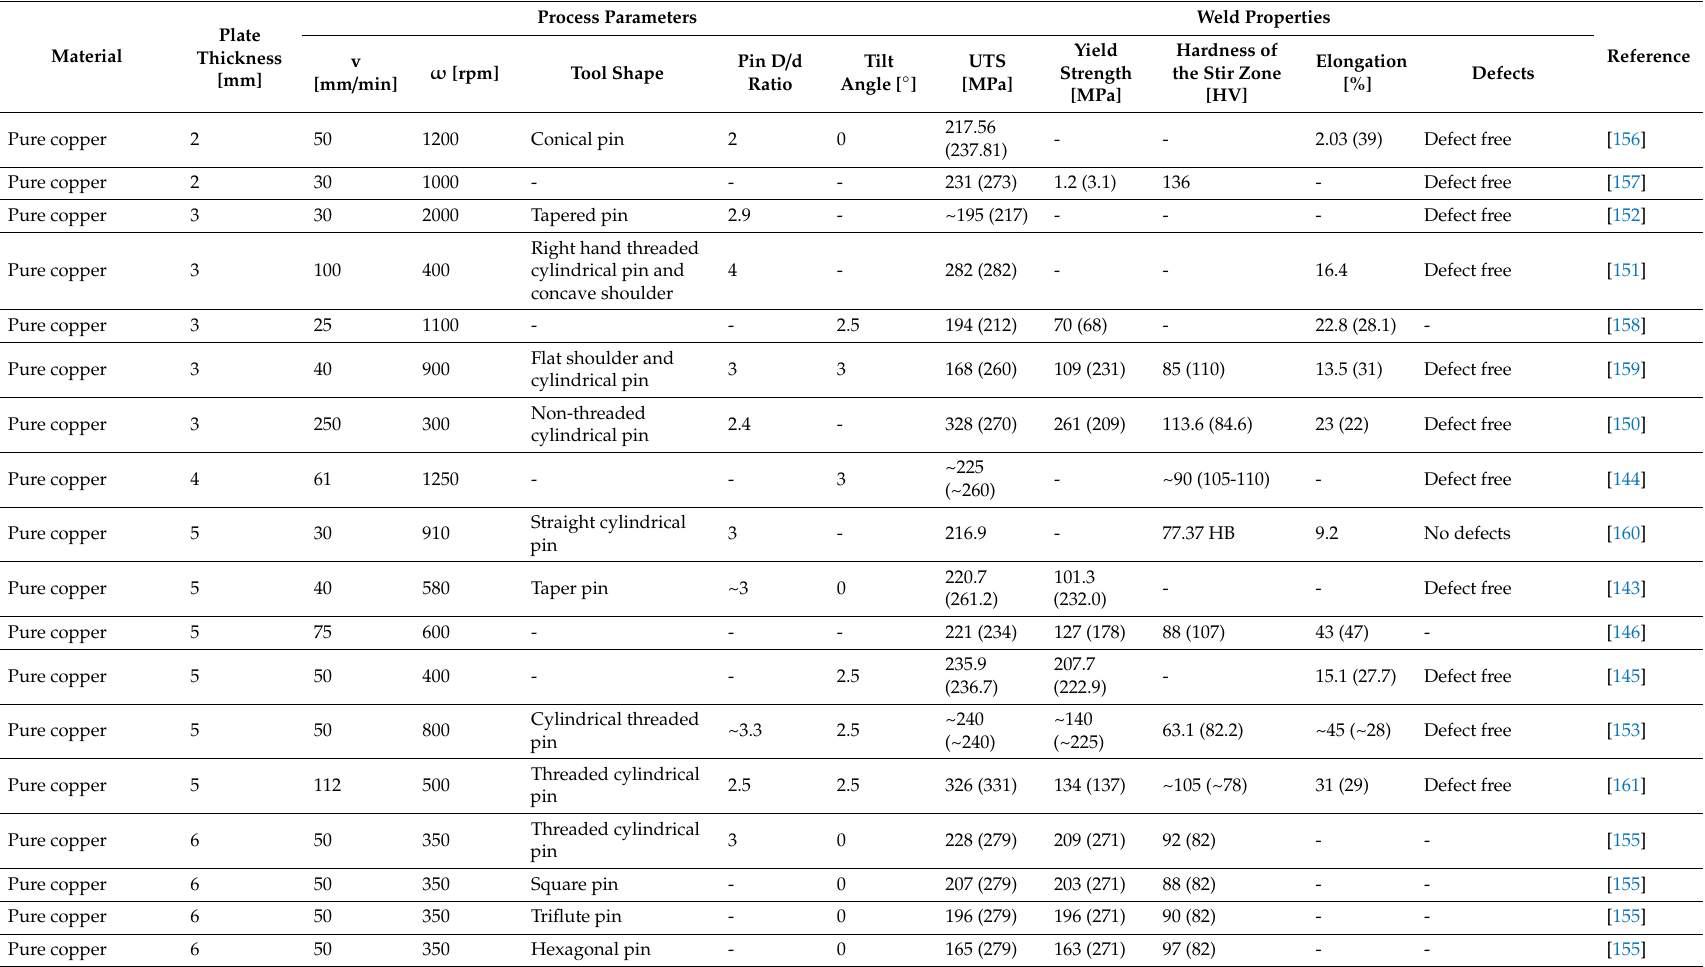
Table 5. FSW of copper and its alloys—process parameters and mechanical properties of the